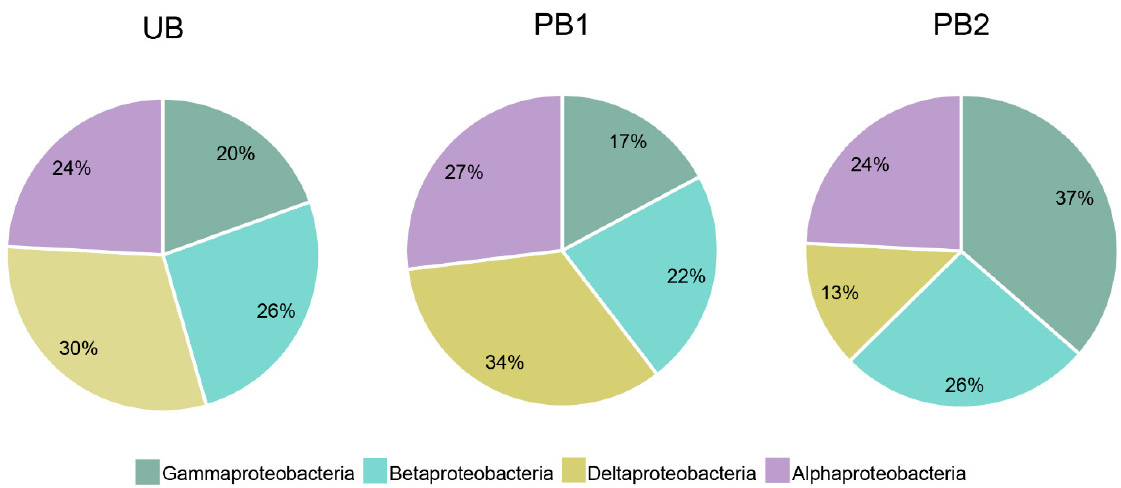
Figure 3. Differences between main classes of the phylum Proteobacteria in different soils treated and not treated with prescribed fire. UB: unburned control soils; PB1: soils treated with prescribed burning seven months before sample collection; PB2: soils treated with prescribed burning immediately prior to sample collection.